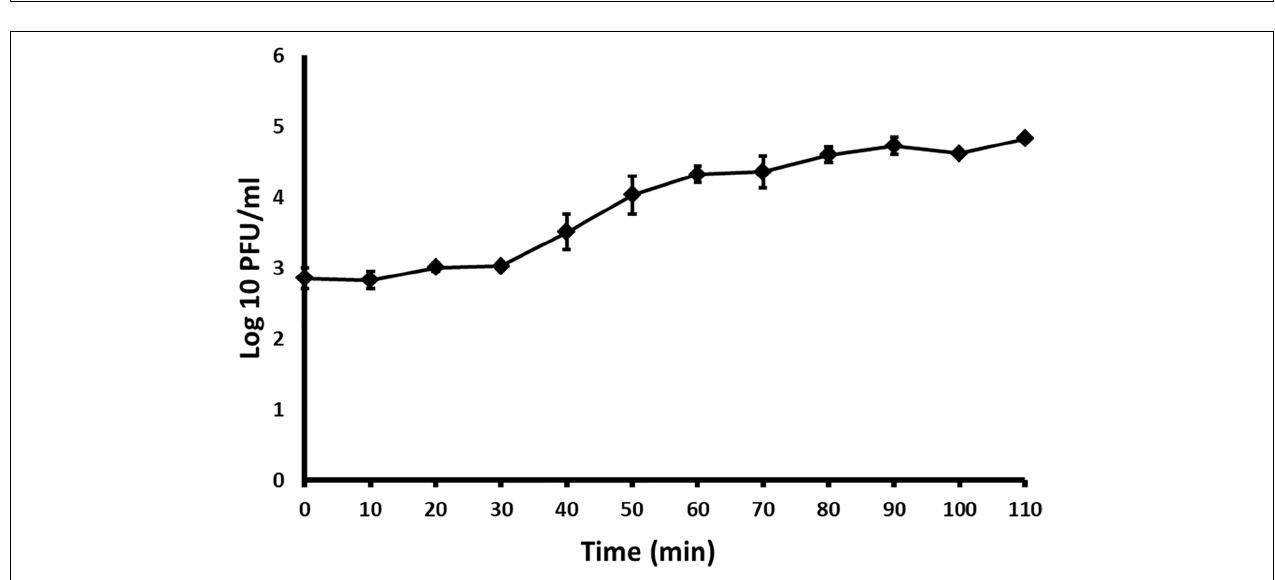
FIGURE 6 | One-step growth curve of Acidovorax phage ACF1 propagated in A. citrulli KBI 86. Means and standard errors from three independent experiments are shown.